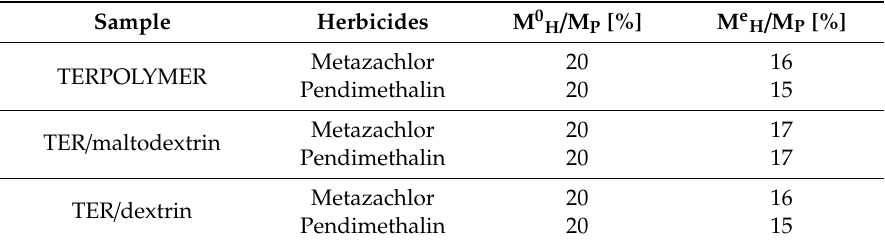
Table 1. Determination of the metazachlor / pendimethalin content in microspheres.